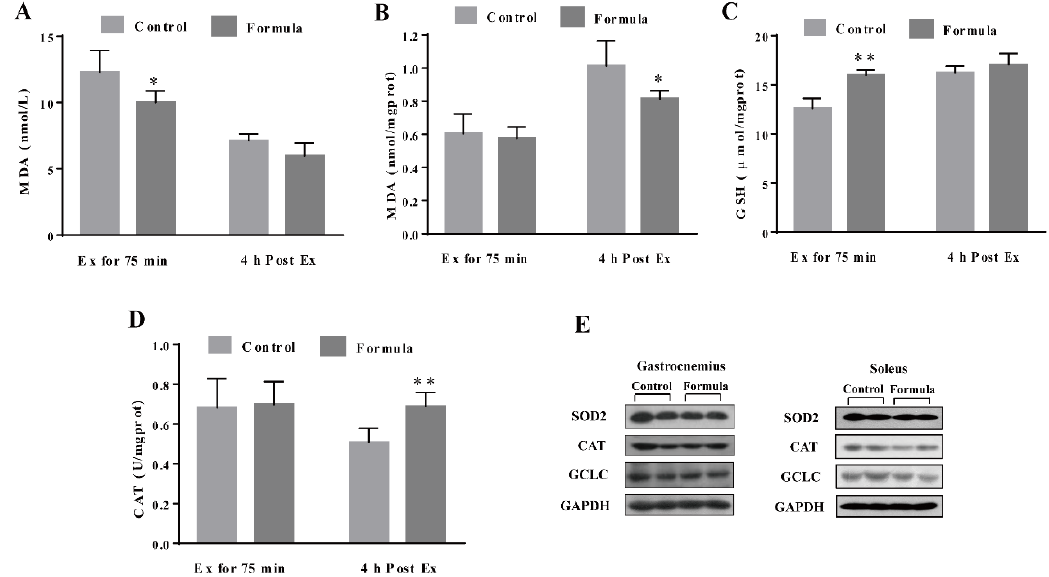
Figure 5. The levels of oxidative stress markers including serum MDA ( A ), and the MDA ( B ), GSH ( C ), and CAT ( D ) in the gastrocnemius muscles of each group after Ex for 75 min and 4 h post Ex for comparison among groups at the same time course. The protein expression in the antioxidant-related pathways in the gastrocnemius and soleus muscles of each group after Ex for 75 min ( E ). Ex: exercise. Ex for 75 min: Exercise for 75 min according to the protocol of the exhaustive treadmill test. 4 h post-Ex: 4 h after completion of the exercise for 75 min. MDA: malondialdehyde; GSH: glutathione; CAT: catalase; GCLC: glutamate-cysteine ligase catalytic subunit; SOD2: Superoxide dismutase 2; GAPDH: glyceraldehyde-3-phosphate dehydrogenase. The light gray column refers to the control group, while the deep gray column denotes the formula group. The data are expressed as mean ± SD, N = 6, * p < 0.05, and ** p < 0.01, compared to the control group at the same time.